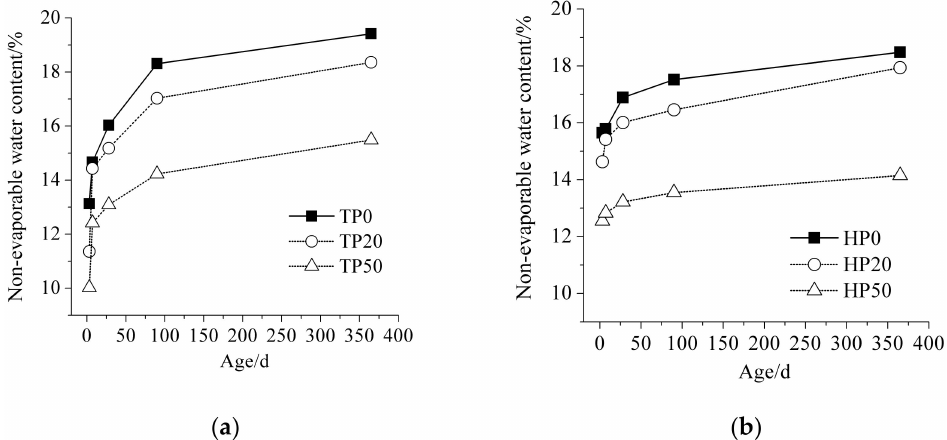
Figure 3. Non-evaporable water content of cement-ITP hardened paste at different curing tempera- tures: ( a ) 20 ◦ C; ( b ) 60 ◦